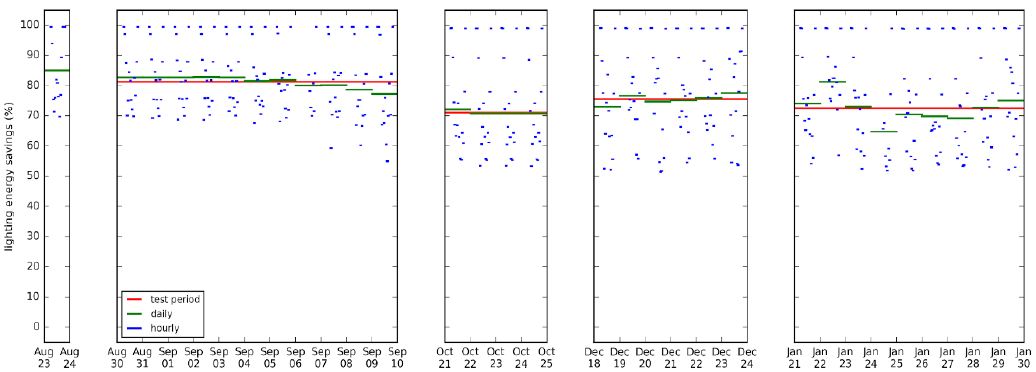
Figure 5. Lighting energy percentage savings for CorePlus-S configuration.